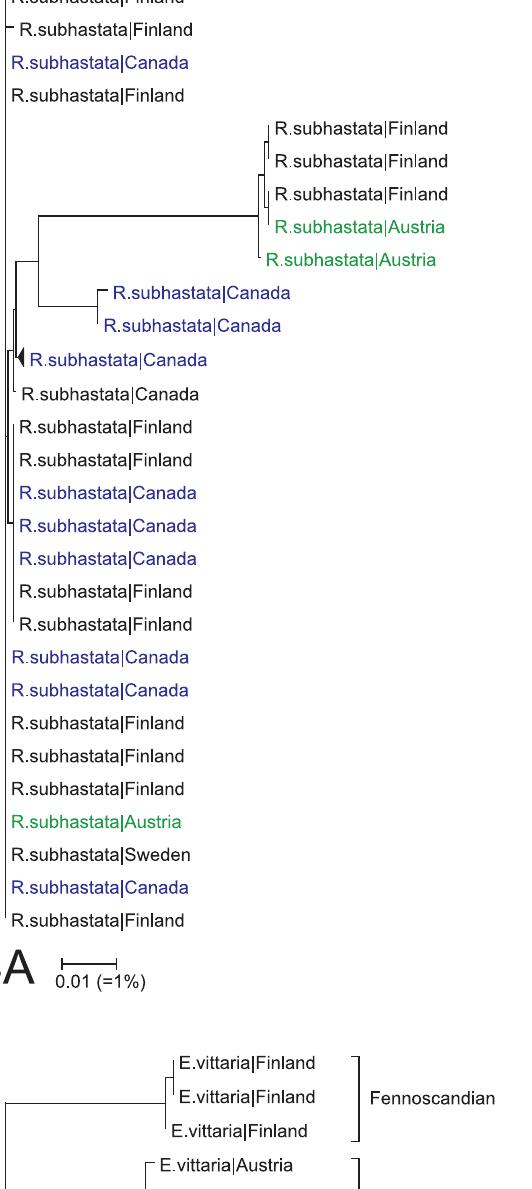
Figure 3. Examples of taxonomic findings. Taxa showing low interspecific divergence (3A. Erebia polaris - E. medusa , 3B. Stenoptilia islandica - S. brigantiensis - S. mercantourica - S. alpinalis , 3C. Xanthorhoe decoloraria - X. alticolata ); taxonomic incongruence (3D. Xanthorhoe annotinata - X.